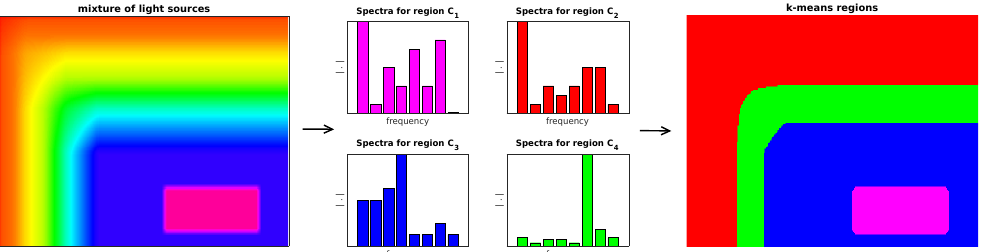
Figure 12. Scheme of the segmentation video sequence using spectral analysis using similarity of the amplitude spectrum for the time domain (false colors were used for better visualization for classes C 1 , C 2 , C 3 , C 4